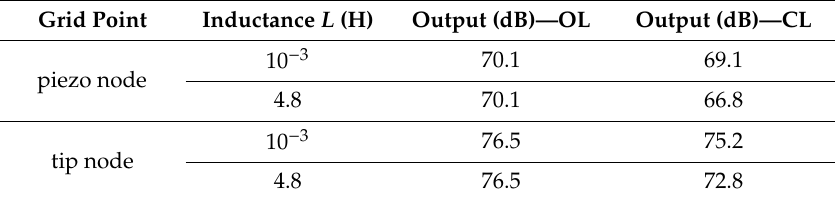
Figure 8. Dynamic displacement of beam (spectrum), circuit with di ff erent inductances. Table 7. SISO simulative gains: open loop (OL) and closed loop